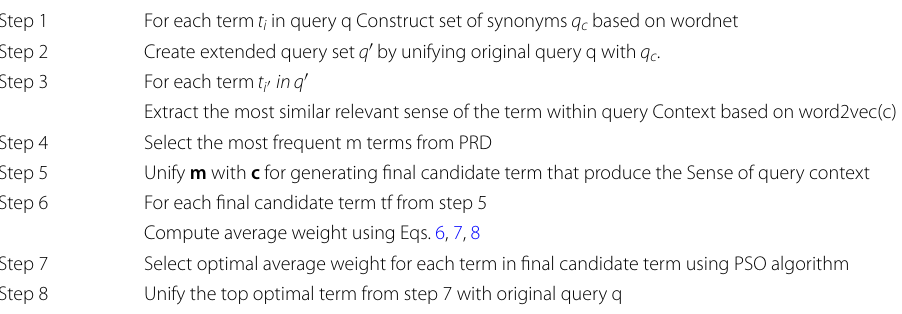
Table 1 Pseudo code of proposed